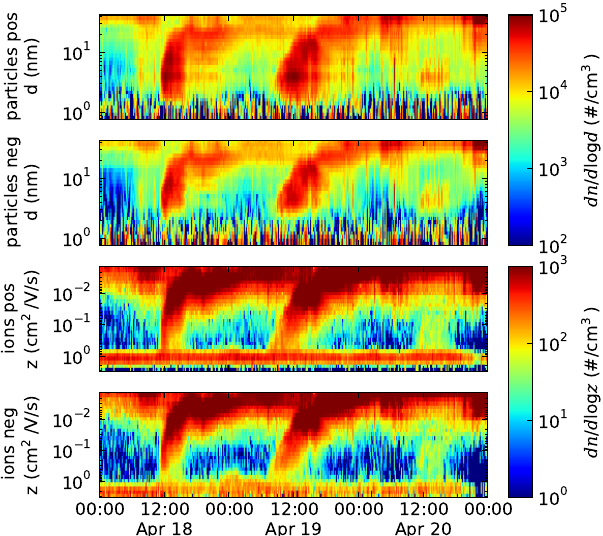
Fig. 8. Typical new particle formation events measured using the NAIS near the town center of Tartu,